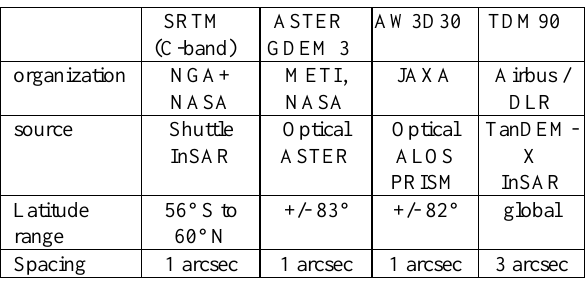
Table 1. Analyzed height models